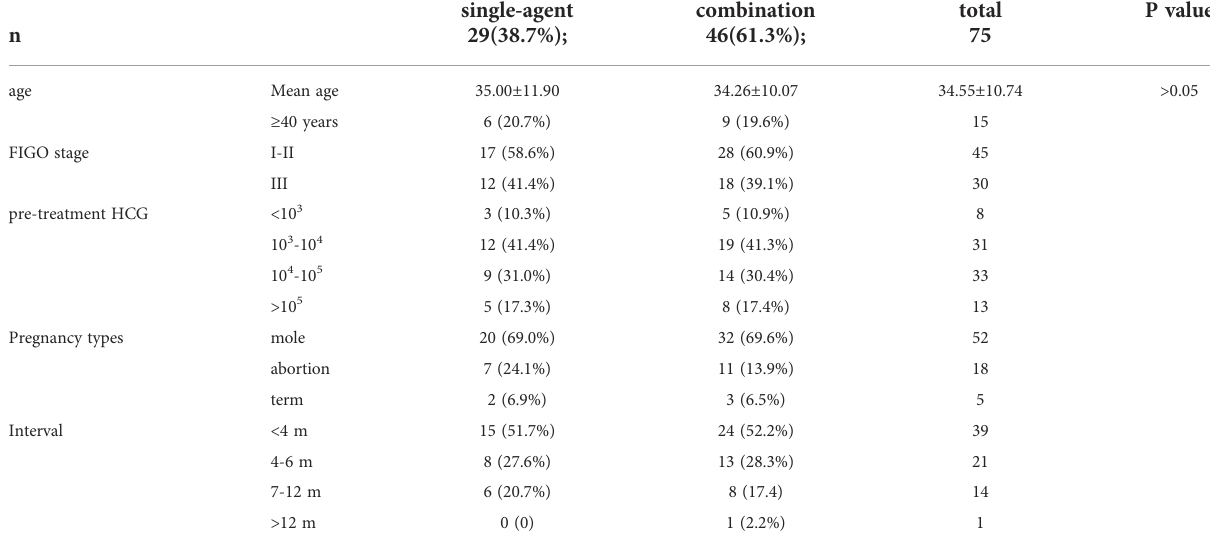
FIGO, International Federation of Gynecology and Obstetrics; WHO, World Health